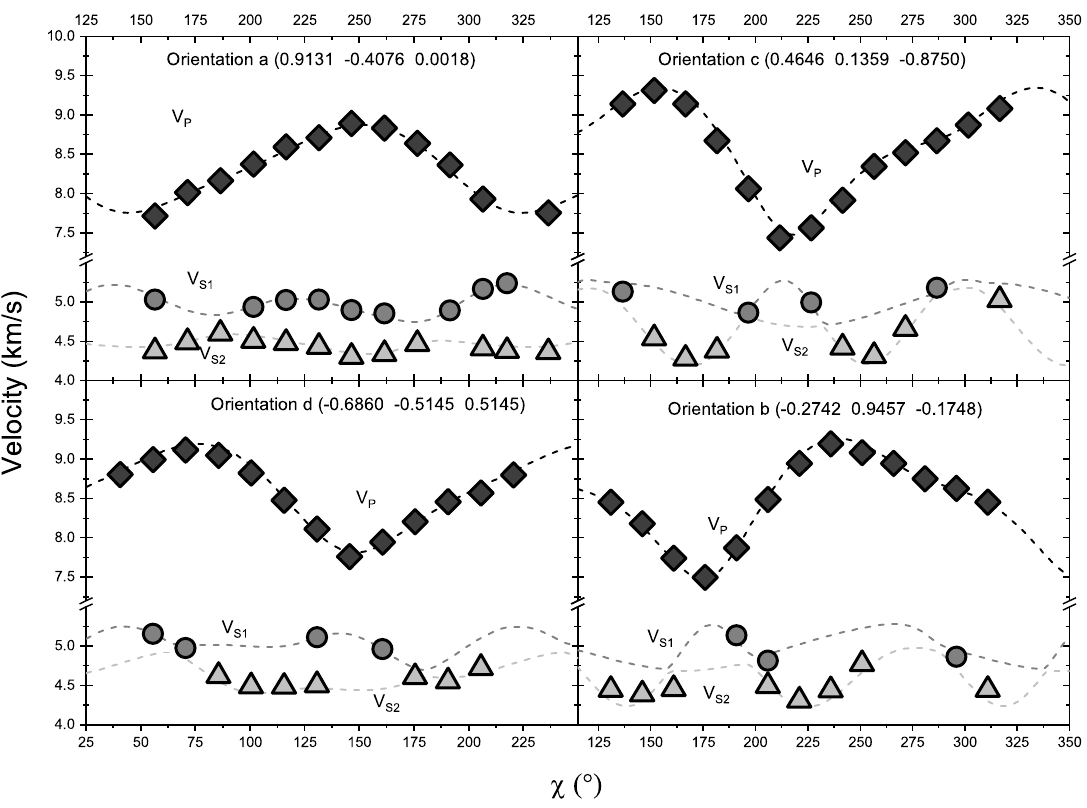
Figure 2. Acoustic velocities measured versus laboratory χ angles for the four orientations of SBB-46. Diamonds, circles, and triangles represent experimentally determined V p , V s1 , and V s2 , respectively. The dashed lines were calculated from the best fit single-crystal C ij model. Errors were smaller than the symbols.